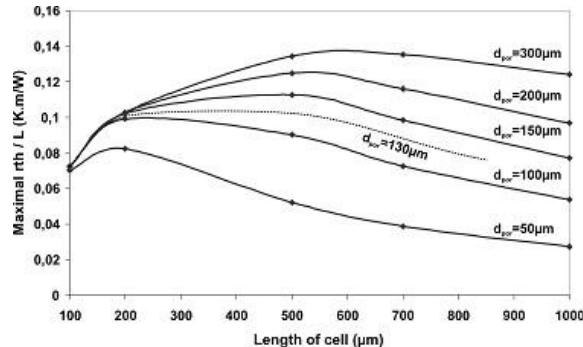
Figure 3. Zoom on an elementary cell of the heat flux microsensor.